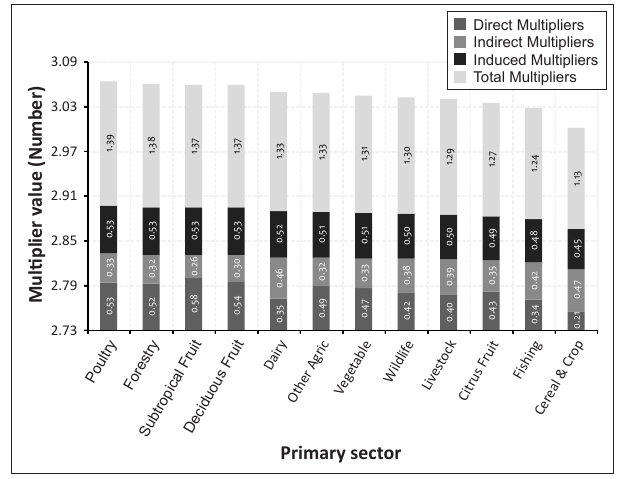
FIGURE 3: Production multipliers vs. percentage labour contribution. FIGURE 4: Gross domestic product/Value added